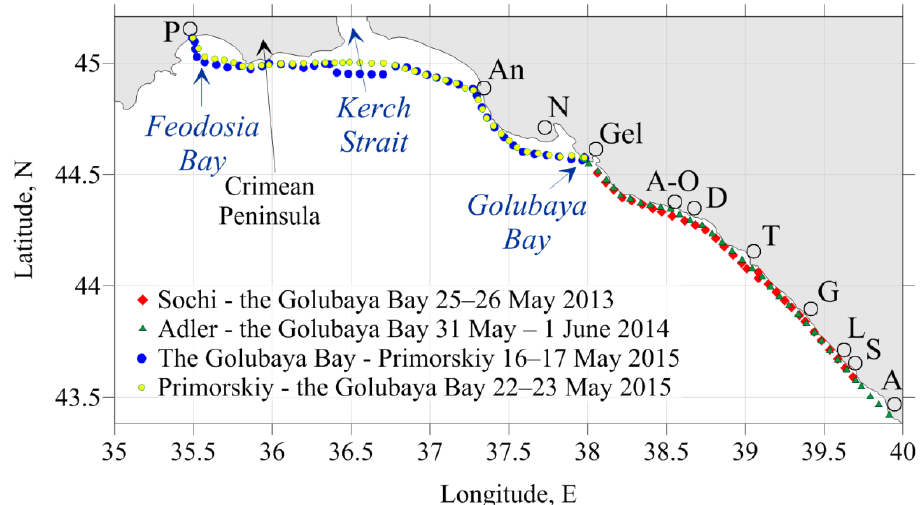
Figure 2. Location of surface water sampling stations on sections in the northeastern Black Sea in